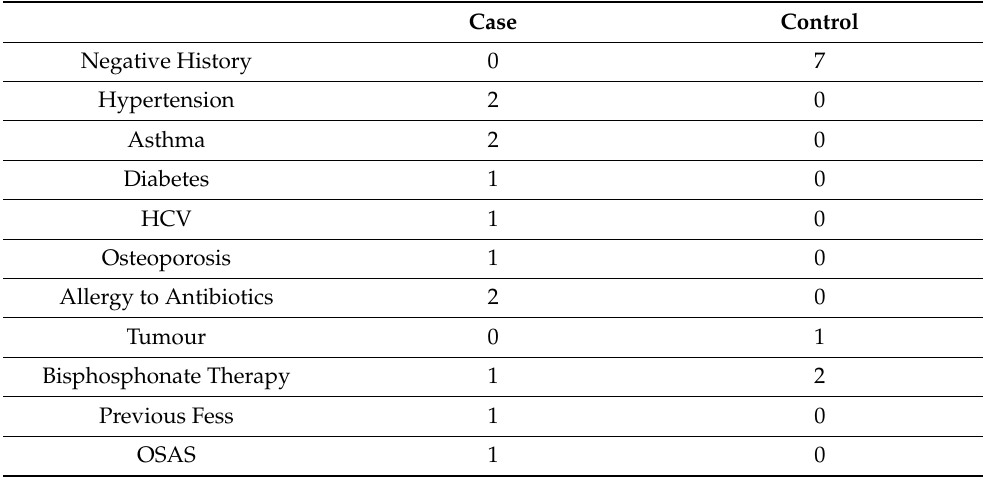
Table 1. Patient